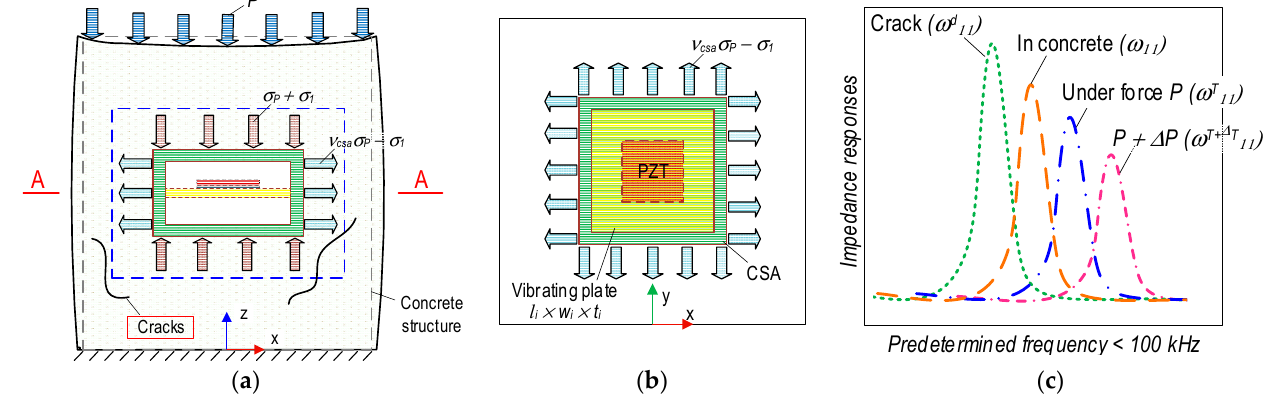
Figure 3. Behavior of CSA in concrete structure under compressive loading. ( a ) CSA in structure. ( b ) PZT interface in A-A. ( c ) Impedance signals.